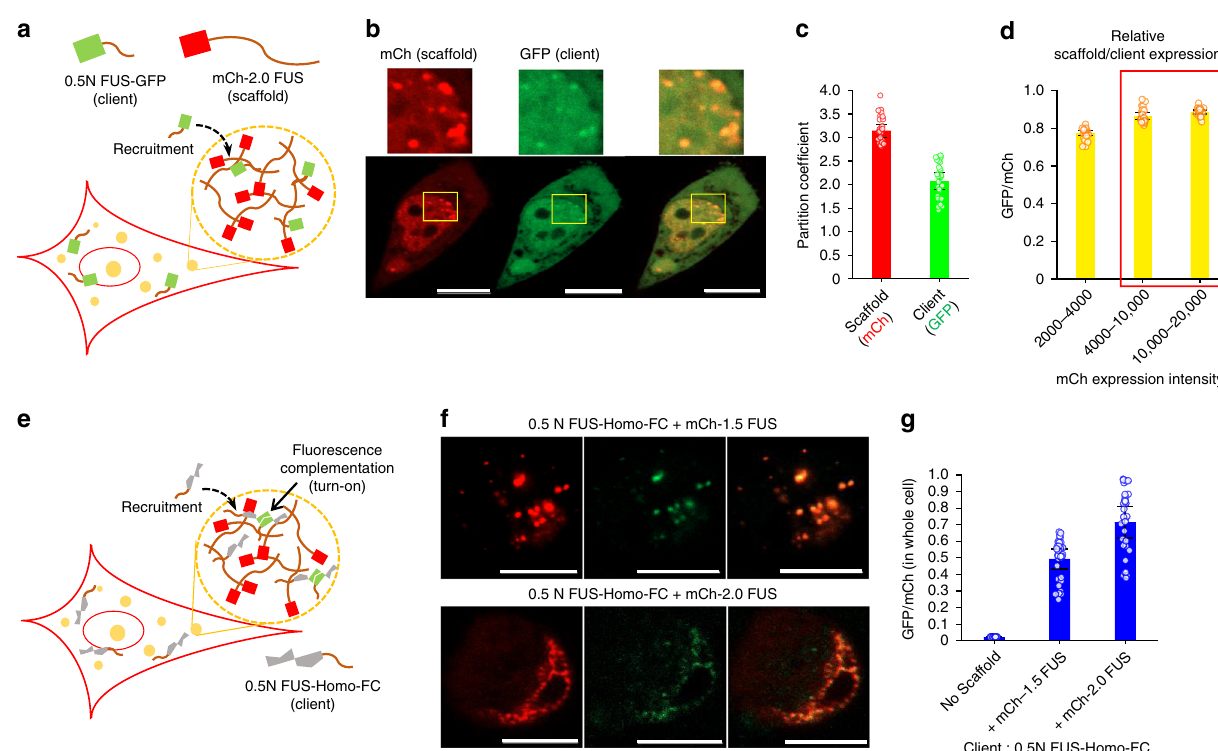
Fig. 3 Fluorescence complementation of recruited client probes inside repeated-IDP compartments. a Schematic illustration of cellular condensate formation of mCh-2.0 FUS and 0.5 N FUS-GFP recruitment. b Fluorescence (mCh and GFP) images of cells expressing mCh-2.0 FUS (scaffold) and 0.5 N FUS-GFP (client). c Partition coef fi cients of scaffold (mCh) and client (GFP) between inside and outside condensates. Data are presented as mean values with ±1 SD as error bars ( n = 33 cells from three independent experiments). d Relative expression levels of 0.5 N FUS-GFP and mCh-2.0 FUS (GFP/mCh). Expression levels are categorized based on mCh expression intensities. Cells with mCh expression intensities between 4000 and 20,000 (red box) were used for data analysis. Data are presented as mean values with ±1 SD as error bars ( n = 30 cells from three independent experiments). e Schematic illustration of cellular condensate formation of mCh-2.0 FUS, 0.5 N FUS – Homo-FC recruitment, and client complementation for (green) fl uorescence turn- on. f Fluorescence (mCh and GFP) images of cells expressing mCh-1.5 FUS or mCh-2.0 FUS (scaffold) and 0.5 N FUS – Homo-FC (client). g Total GFP (complemented Homo-FC)-to-mCh ratios for cells without (no scaffold) or with 1.5 FUS and 2.0 FUS condensates. Data are presented as mean values with ±1 SD as error bars ( n = 33 cells from three independent experiments). Scale bars: 10 μ